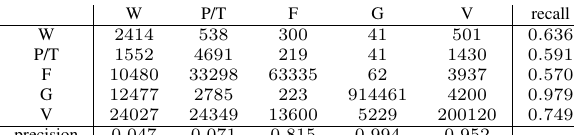
Table 1: Confusion matrix resulting from SVM-based classifica- tion with all 3D and 2D features (W: wire, P/T: pole/trunk, F: fac¸ade, G: ground, V: vegetation). The reference labels are pro- vided in the left column, the estimated labels are represented in the upper row. The overall classification accuracy is 89 . 48% .